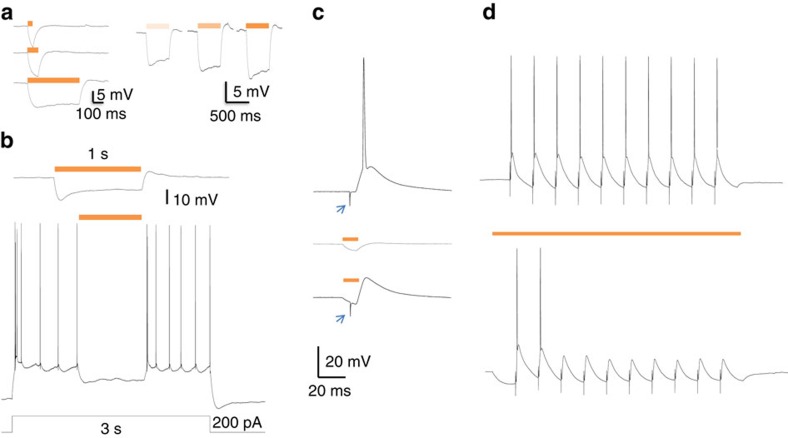
Halorhodopsin inhibition of BLA Thy-1 neurons.(a) Light activation of halorhodopsin (593 nm) induced membrane hyperpolarization in a Thy-1 neuron; strength of hyperpolarization is time and intensity-dependent. (b) Halorhodopsin activation abolished inward current injection-induced firing; (c) upper, electrical stimulation of lateral amygdala induced action potential in a BLA Thy-1 neuron; middle, light evoked membrane hyperpolarization in Thy-1 neuron; bottom, the action potential was abolished by light illumination; arrowheads indicate stimulus artifact from LA stimulation. (d) Upper, a train of action potentials induced by 10 Hz electrical stimulation of LA, lower, the firing was reduced by concurrent halorhodopsin activation. Delays in action potential suppression are likely due to transient and complex dynamics of intrinsic ion channels during eNpHR facilitated hyperpolarization. Similar delays were found in original characterizations of Thy1-NpHR mouse lines. For additional characterization of NpHR and eNpHR in Thy1 mouse lines, please see refs 18, 19.